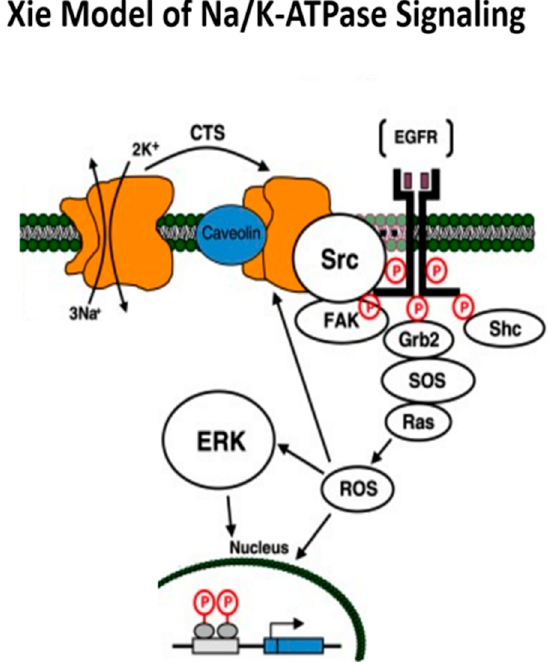
Figure 2. Xie Model of Na/K-ATPase Signaling. In this model, cardiotonic steroids (CTS) induce the Na/K-ATPase signal cascade, which eventually leads to the development of ROS. We suggest that in the microdomain of caveolae, the Na/K-ATPase functions as a scaffolding protein to interact with CTS and change conformation to activate Src. Src then transactivates the EGFR, which leads to a signal cascade involving FAK, Shc, Grb2 and SOS resulting in the generation of ROS, which in turn activates additional Na/K-ATPase molecules, as well as causes downstream activation of ERK and effects nuclear transcription. Abbreviations: Epidermal growth factor (EGFR); focal adhesion kinase (FAK); Src homology 2 domain protein (Shc); growth factor receptor bound protein 2 Grb2); son of sevenless protein (SOS); extracellular-signal-regulated kinase (ERK).